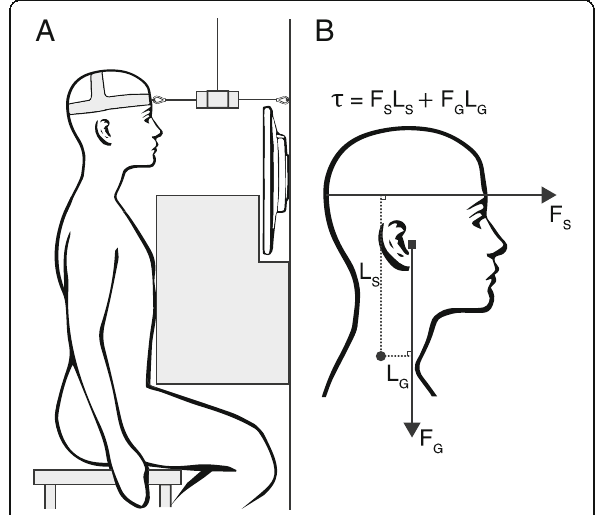
Fig. 2 Schematic diagrams of the data sampling setup and torque calculation. a shows body positioning during neck extensions with a square block stabilizing the spine in a neutral posture, arms hanging slack beside the torso, and legs placed to prevent them from aiding during trials. A wall-attached force transducer, supported by a sling from the roof, is fixed to a strap that is level with the supraorbital ridge. Visual feedback is provided by a monitor on the wall. During neck flexions, subjects are reversed 180°, facing an additional monitor (not shown in figure). b shows the neck extension torque ( τ ) formula along with a visual description of its variables: the resistance force of the strap ( F S ), the force on the center of mass of the head and neck ( filled square ) due to gravitational acceleration ( F G ), and their respective lever arms ( l S and l G ) originating from the axis of rotation between the C7 – T1 spinous process ( filled circle